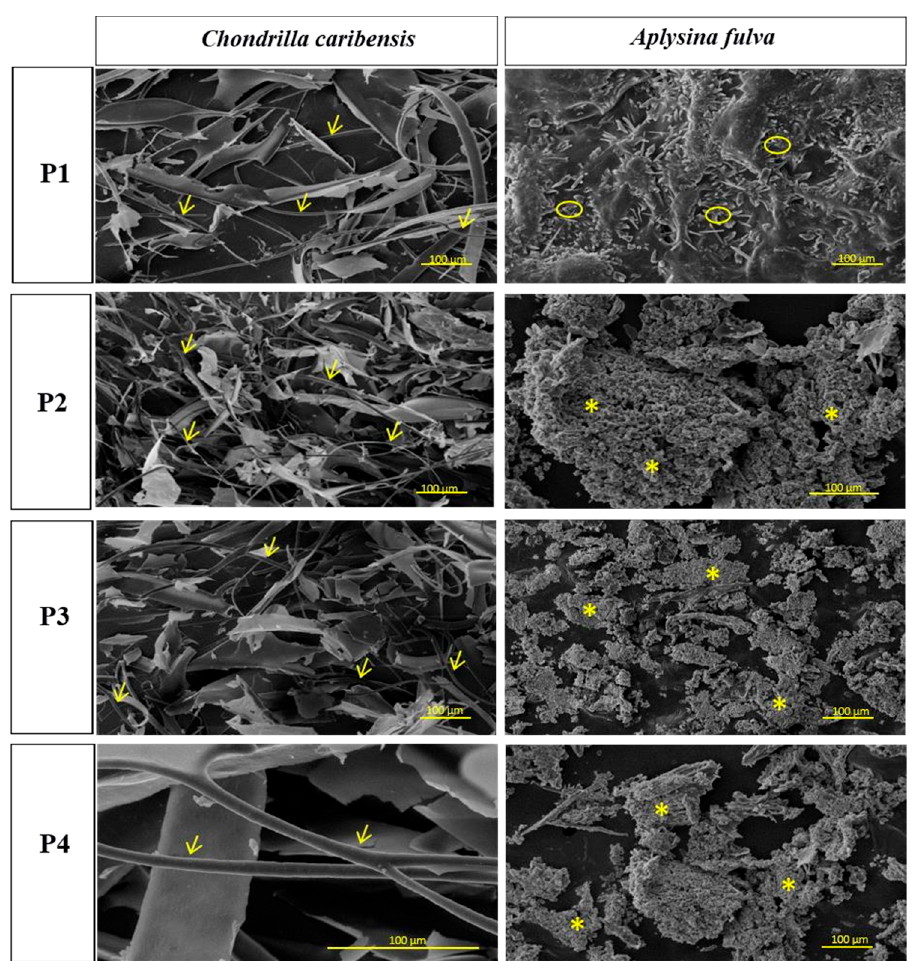
Figure 2. SEM micrographs of freeze-dried crude extracts. It is possible to observe fibrillar SC in all C. caribensis extracts ( ). For A. fulva , a nodular/particulate material was depicted in P2, P3, and